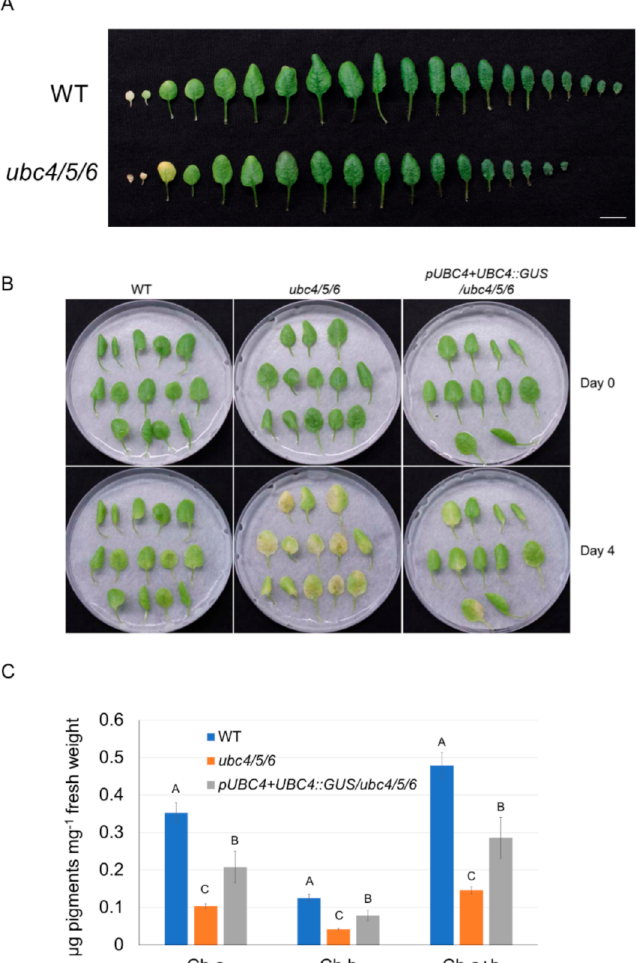
Figure 6. Analysis of early leaf senescence phenotype in the ubc4/5/6 triple mutant plants. ( A ) Individual leaves were detached from representative WT and ubc4/5/6 mutant plants at the 5-week stage and are shown from the oldest to the youngest. Scale bar: 1 cm. ( B ) Dark-induced senescence of detached leaves of the WT, ubc4/5/6 mutant, and the ubc4/5/6 mutant expressing pUBC4::UBC4-GUS . The second pair of true leaves were detached from 5-week-old plants and placed in Petri plates on a piece of filter paper with 4 mL of H 2 O added to keep the moisture. The plates were covered with a layer of lab bench absorbent paper to reduce the amount of light and incubated at room temperature for 4 days. Pictures were taken before (Day 0) and after the dark treatment (Day 4). ( C ) Chlorophyll content analysis of the detached leaves after the 4-day dark treatment in ( B ). Each datum (in µ g of pigments per mg of fresh weight) represents the average of three replicate samples (with each sample having five detached leaves analyzed). The error bars indicate standard deviations. Data were analyzed using one-way ANOVA and post-hoc Tukey test, and significant differences are indicated by different letters (upper case) at p < 0.01